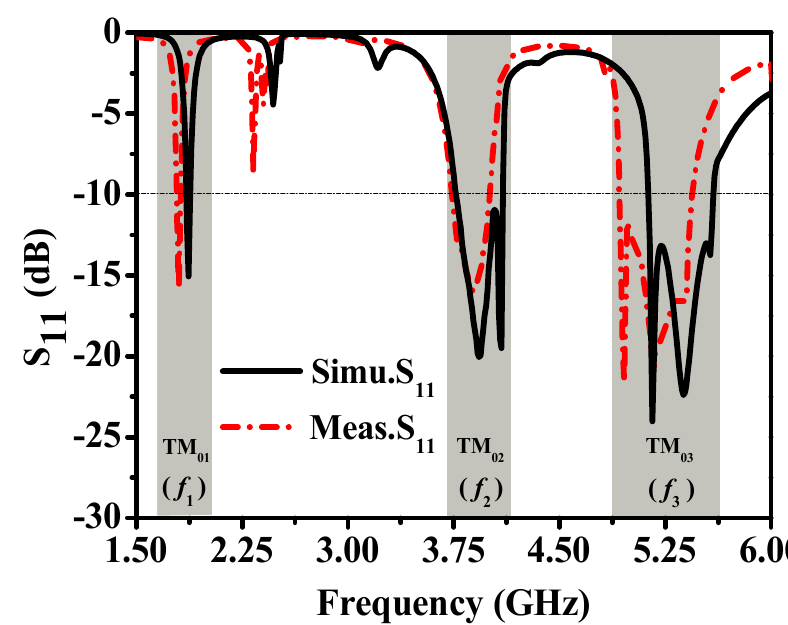
Figure 9. Comparison of simulated results and measured results of the S 11 .